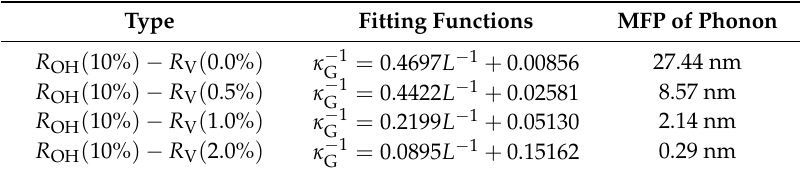
Table 1. The mean free path (MFP) of phonon for four types of defect ratio in GO.